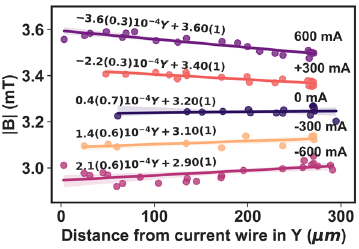
Figure 5. The magnetic field strength plotted as a function of distance from the current wire in Y direction for different curve values. The colored solid lines are the linear-fit to the data and the shaded area show the 95 % confidence